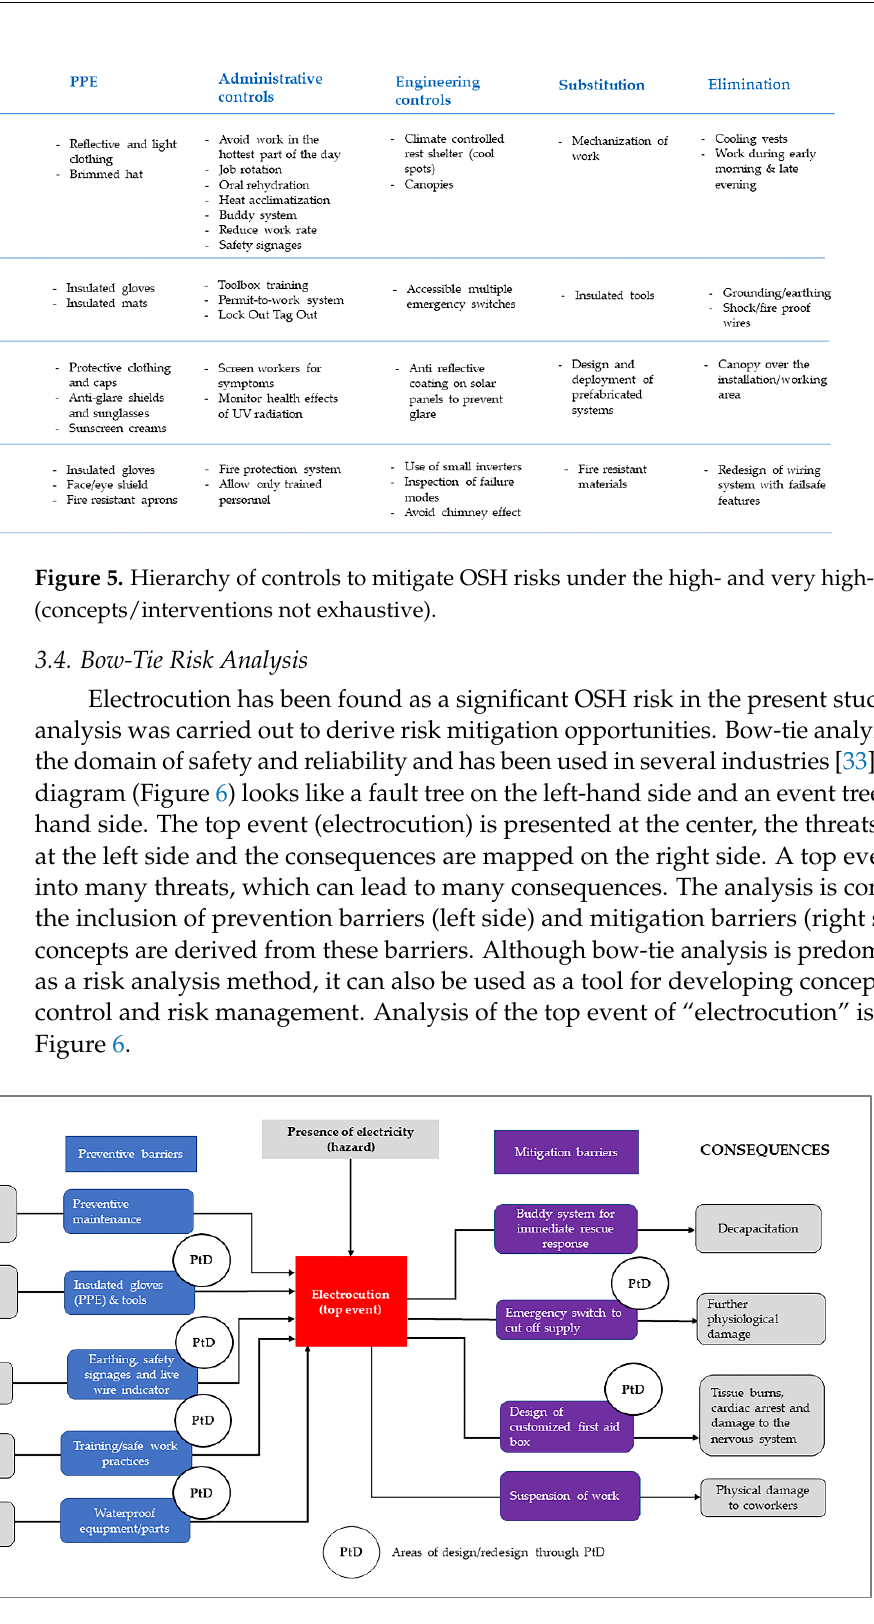
Figure 6. Bow-tie analysis of the top event of “electrocution” .